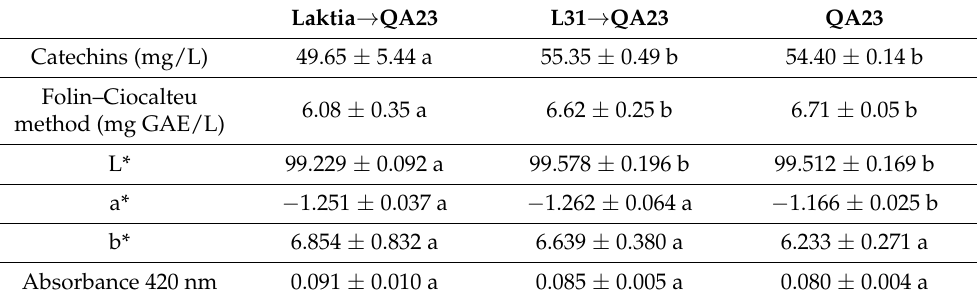
Table 2. Flavonoid compounds and colour (CIE 1976 L*a*b*) of the different yeasts on the last day of fermentation. Different letters in the same row indicate statistically significant differences according to the Student–Newman–Keuls (S–N–K) test. α =